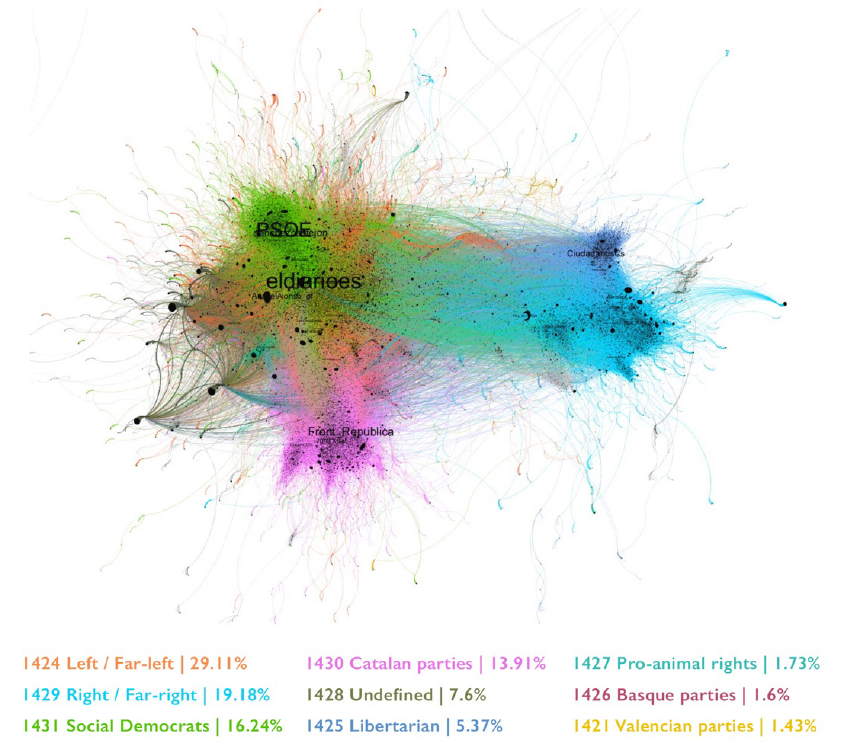
Figure 1. The main communities in the retweet network. Note: Numbers to the left of the labels are codes.